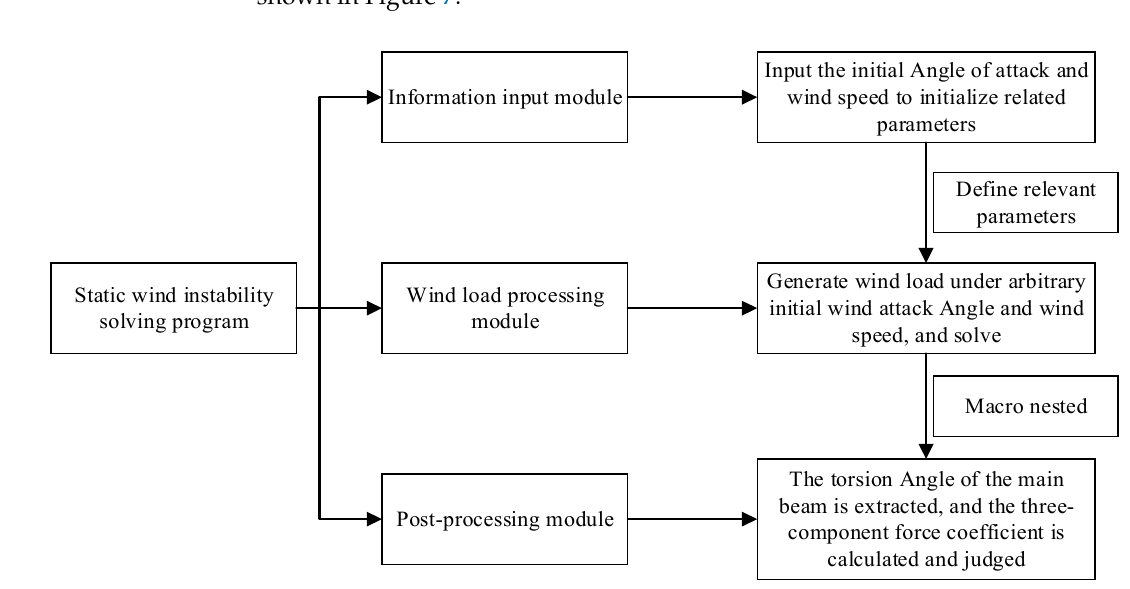
Figure 7. Flowchart of the static wind instability solution program.